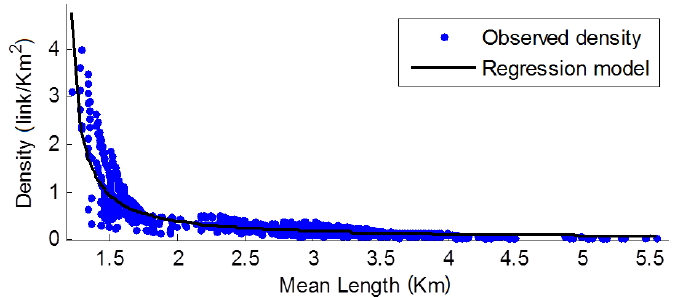
Figure 5. The empirical relationship between a CML’s density and mean length in a given region. The black curve was derived through non-linear regression [13].